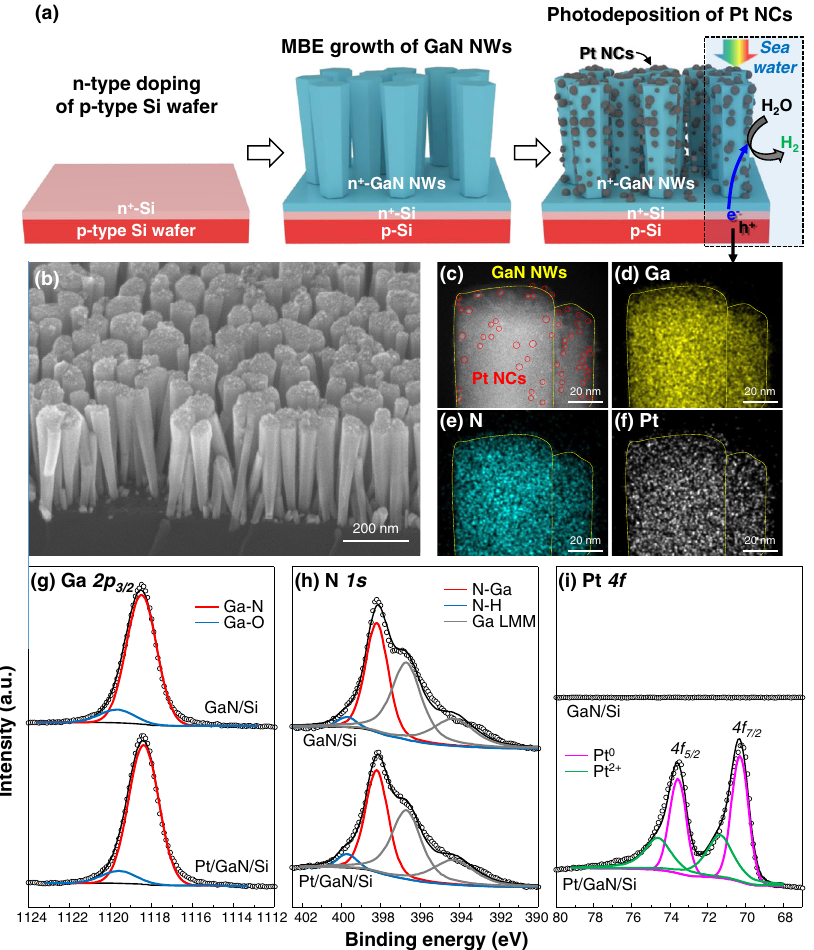
Fig. 1 | Pt nanoclusters on GaN nanowires grown on n + -p Si wafer. a Schematic illustrationofthefabricationofPt/GaN/SiphotocathodebyepitaxialgrowthofGaN nanowires (NWs) on Si p-n wafer and photodeposition of Pt nanoclusters (NCs). b 45°-tilted-view SEM image of Pt/GaN/Si. c HAADF-STEM image of Pt/GaN